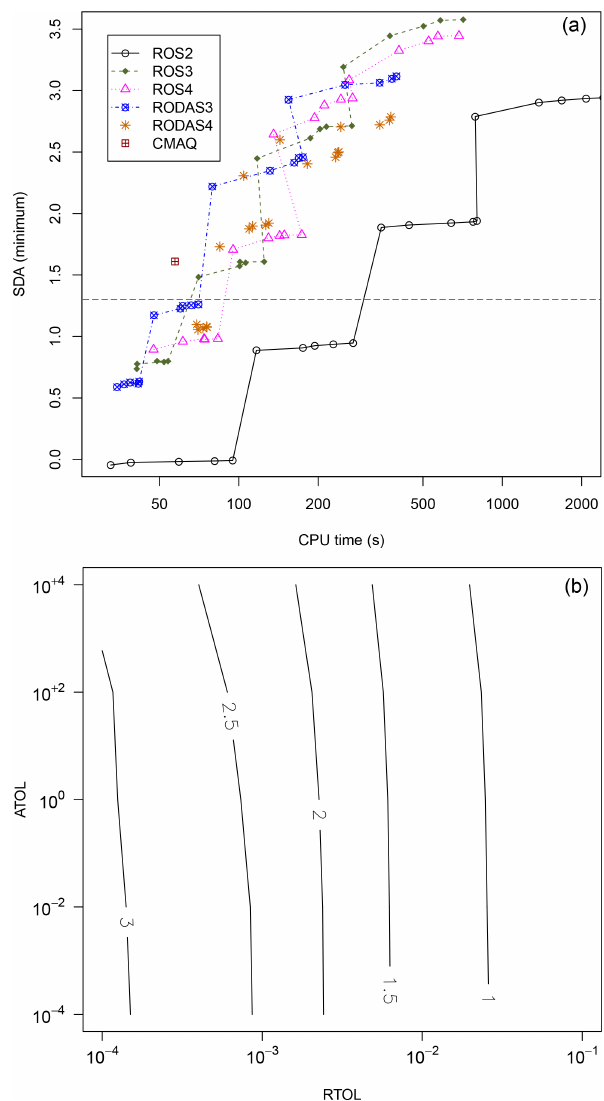
Figure 1. Significant digits of accuracy (SDAs) for the CMAQ species with the maximum error for (a) different variants of Rosen- brock solvers and (b) the Rodas3 solver at different combinations of relative and absolute tolerance. Each point in (a) represents a differ- ent relative and absolute tolerance combination. The absolute toler- ances tested were 10 − 4 , 10 − 2 , 10 0 , 10 2 , and 10 4 moleculescm − 3 air for relative tolerances of 10 − 4 , 10 − 3 , 10 − 2 , and 10 − 1 . Each “plateau” visible for certain solvers in (a) represents a different relative tolerance setting, with tighter tolerances leading to higher